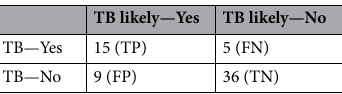
Table 6. Confusion matrix for the pilot testing